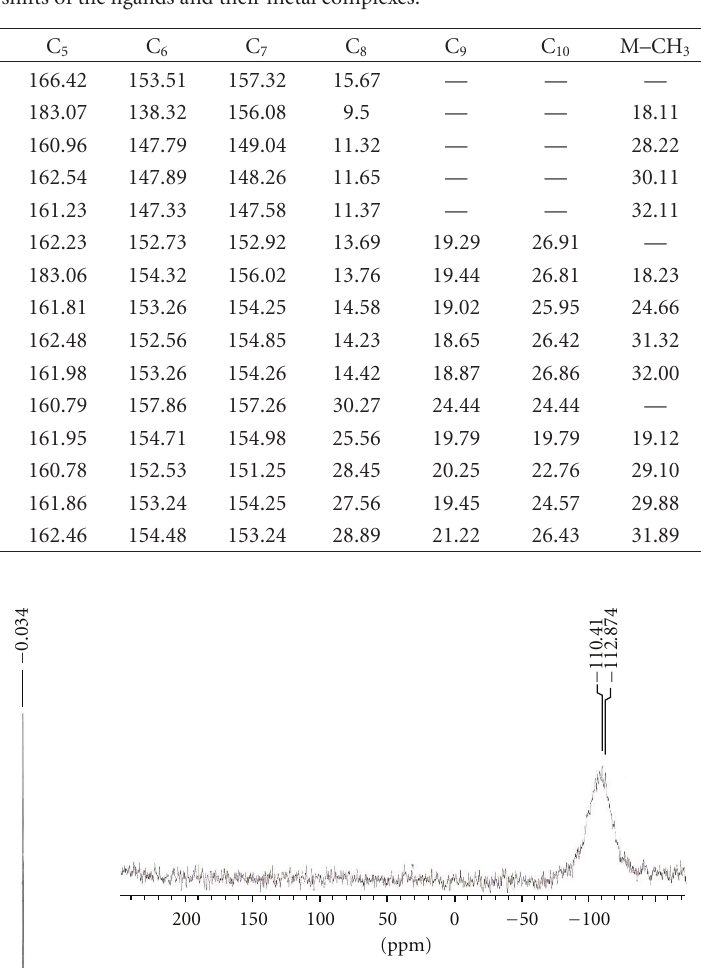
Figure 4: 29 Si NMR spectrum of Si (1:1) metal complex of ligand (HL 1